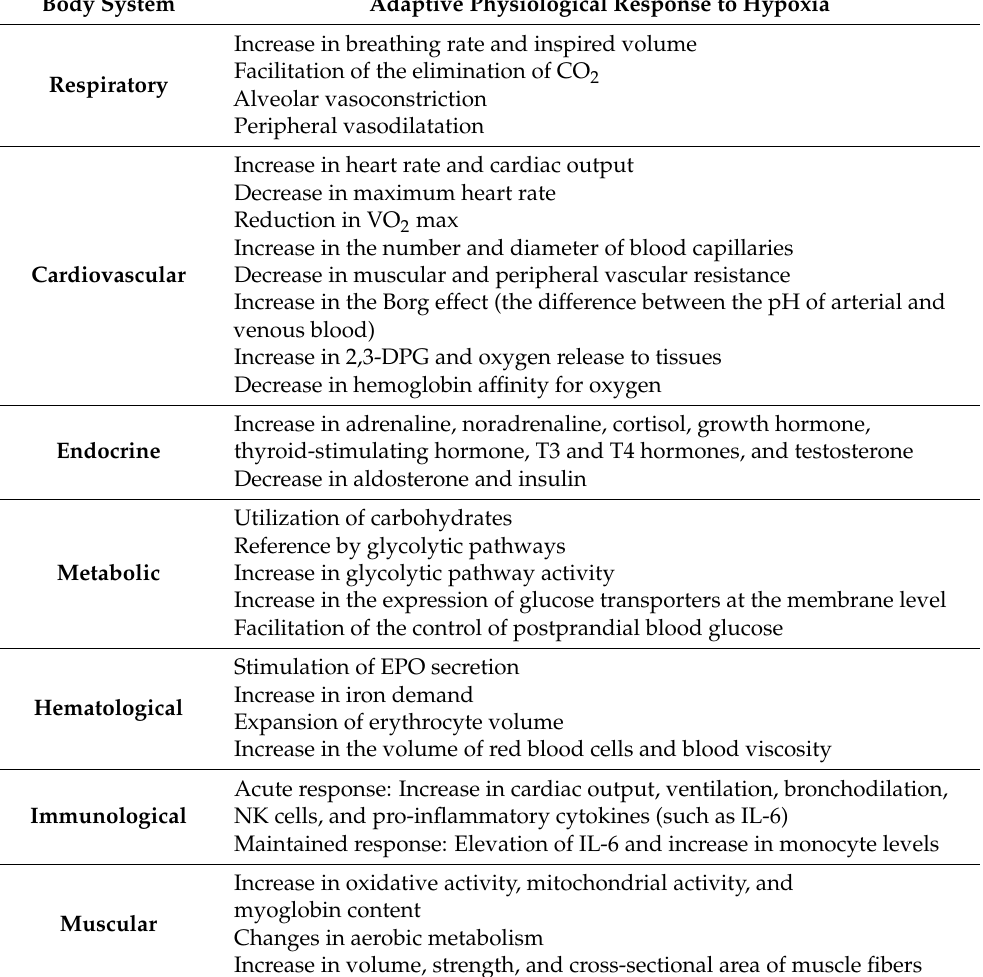
Table 1. The changes that are caused by hypoxia in the different body systems. Adapted with permission from Fern á ndez-L á zaro et al. [2]. Body System Adaptive Physiological Response to Hypoxia Increase in breathing rate and inspired volume Facilitation of the elimination of CO 2 Respiratory Alveolar